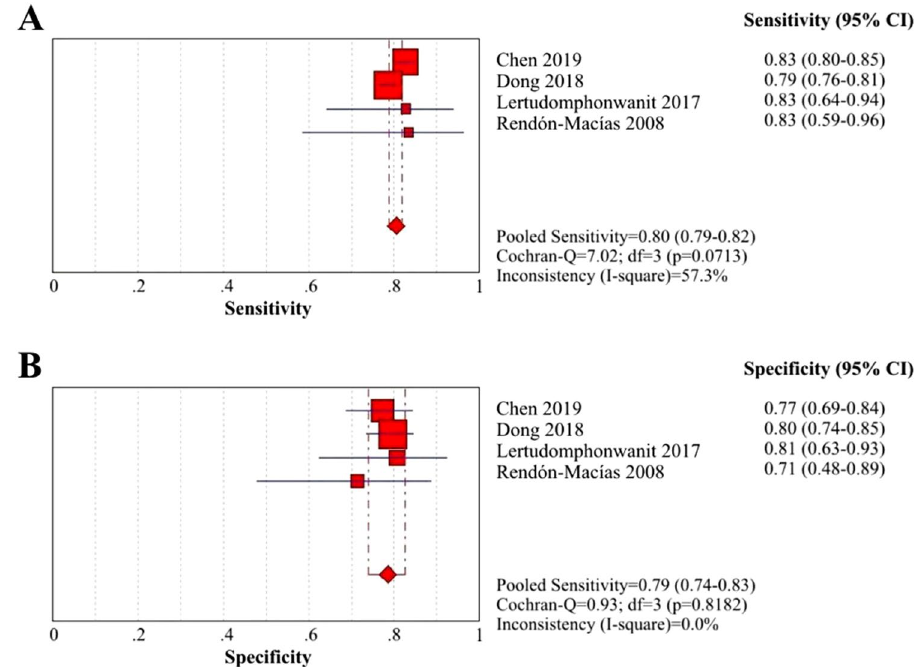
Figure 5. Coupled forest plots of the sensitivity and specificity of GGT for BA diagnosis. ( A ) Sensitivity of GGT for BA diagnosis; ( B ) Specificity of GGT for BA diagnosis.